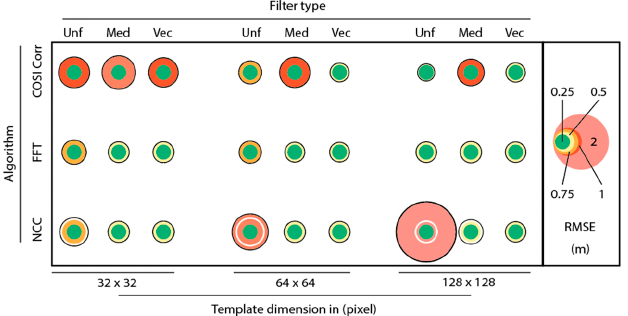
Figure 2. Accuracy of 54 DIC runs based on their respective RMSE value; used scan window size varies from left (32 × 32 pixels) to right (128 × 128 pixels). The subcolumns display results derived with different postprocessing filters: Unf) unfiltered, Med) median filter, and Vec) vector filter. The top row represents COSI Corr, the center row an FFT approach, and the bottom row an NCC approach. The maximal extent of the displayed circle indicates the run’s RMSE, while internal white circles indicate runs whose accuracies were improved by Wallis filtering. Color coding underlines the RMSE with green colors indicating small errors, and red colors representing larger errors. The green centered circle indicates the assumed minimum sensitivity of the technique of around 0.25 m, or 1 pixel.